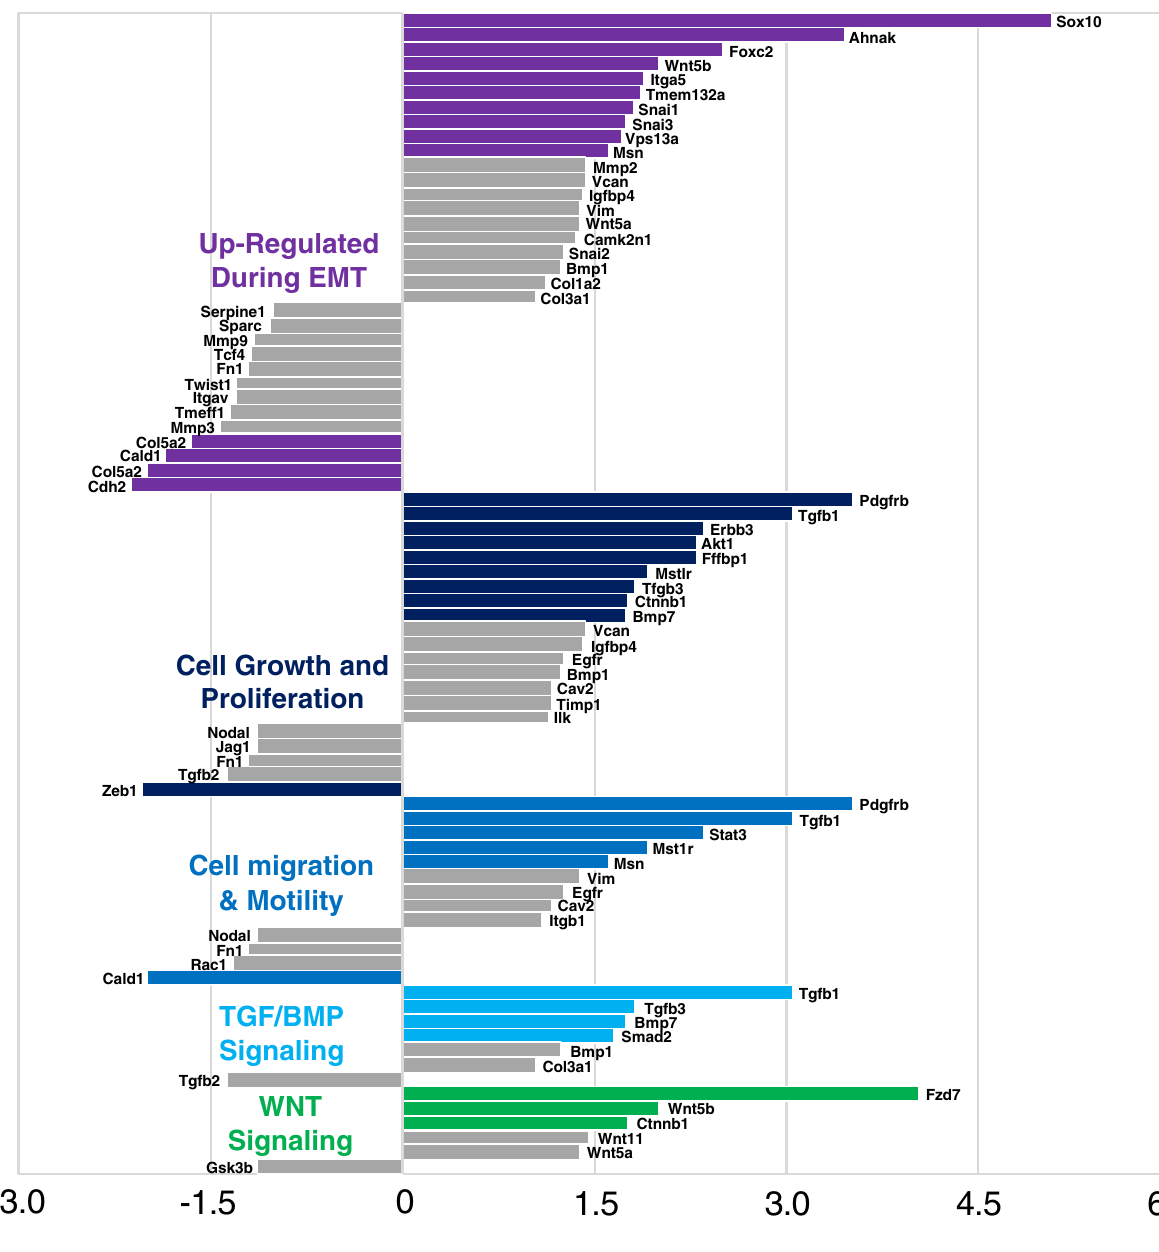
Figure 3. Tissue PCR array analysis about EMT associated components in murine wounds. Eighty-four EMT associated components were examined in RNA extracted from whole wounds at day 4 treated with vehicle or FGF2 (n = 3/group). Genes were categorized into five groups, including genes typically upregulated during EMT, cell growth and proliferation genes, cell migration and motility genes, genes related to TGF/bone morphogenetic protein (BMP) signaling, and genes related to Wnt signaling. Genes indicated with colored bars were up or down-regulated > 1.5 fold